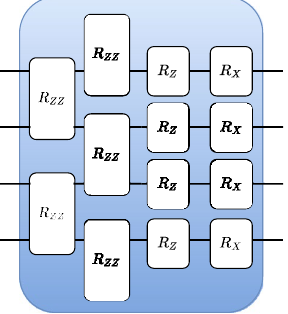
Figure 2. A layer of the unitary ansatz used in our experiments, inspired by QAOA for the 1D Ising model. R Z and R X are parametrized rotations around the corresponding axis, and R ZZ